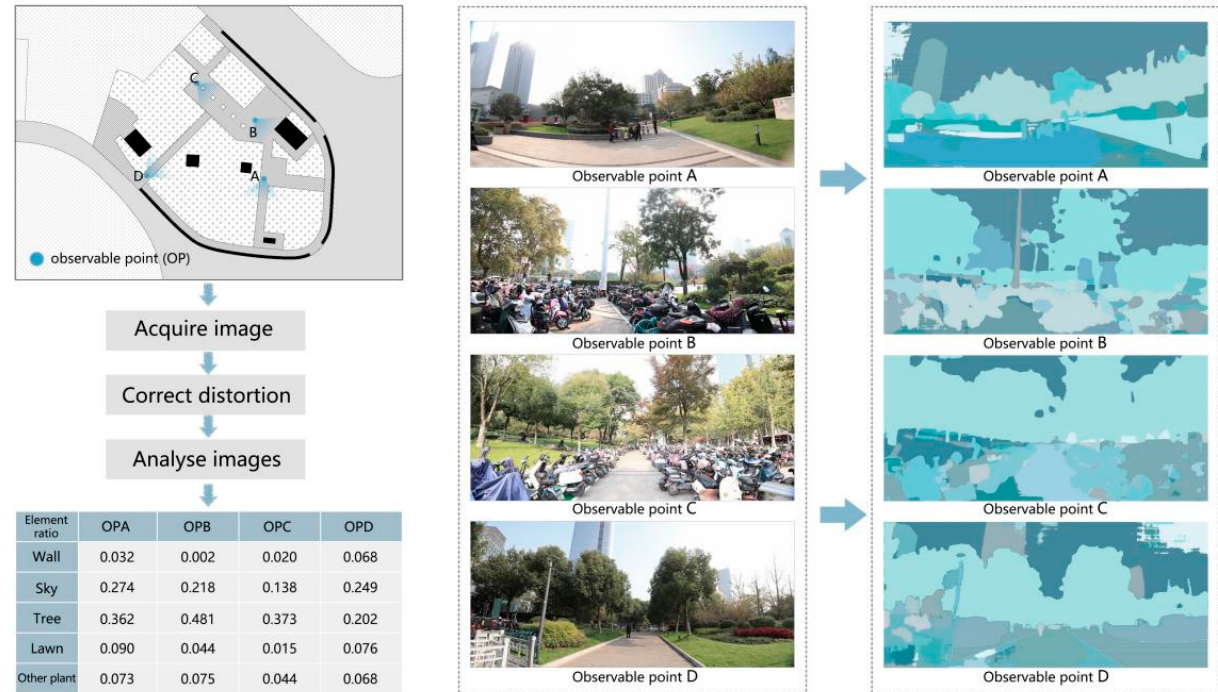
Figure 6. Schematic illustration of the collection method of the average visual green quantity.